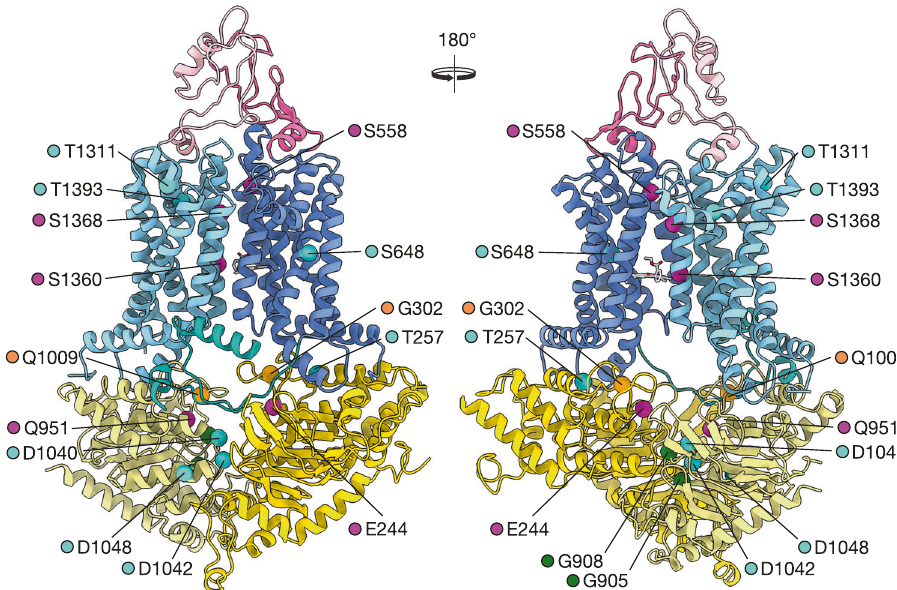
Fig. 8 Mapping of known mutations of Pdr5. Functional mutants of Pdr5 found in literature (see: Supplementary Table 5) are mapped onto the cartoon representation of inward-facing Pdr5 structure (R6G-Pdr5). Front and back views are shown. Mutations are highlighted as coloured spheres centred on the C α of the residue, while the bound ligand, rhodamine 6G, is shown in sticks representation. Mutations that inactivate Pdr5 are labelled with green spheres, those that confer or alter drug resistance with orange and cyan spheres, respectively. Those with other, different phenotypes (see: Supplementary Table 5) are highlighted with magenta. Colour-coding of domains of Pdr5 is identical to Fig. 1 and used